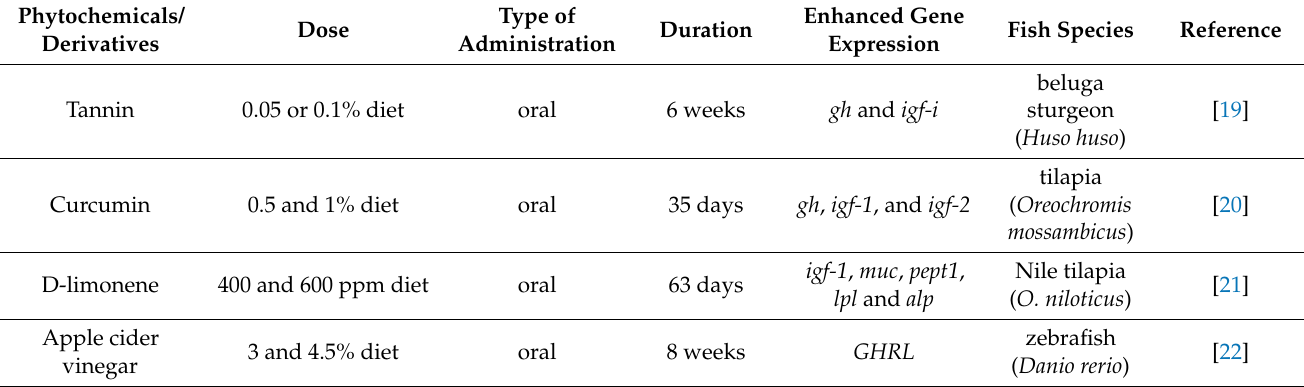
Table 1. Selected studies regarding phytochemicals and their derivatives effects on growth-related genes. Phytochemicals/ Type Dose Derivatives